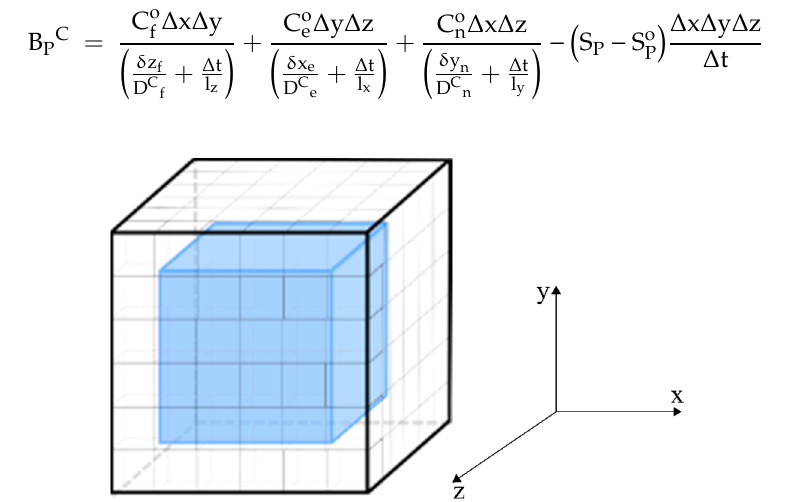
Figure 4. Internal control volumes.